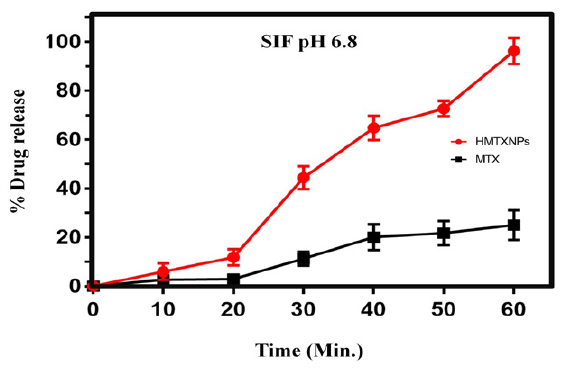
Figure 9. Dissolution profiles of optimized NS (MTX-NS) with a pure drug in simulated intestinal fluid (SIF) with pH